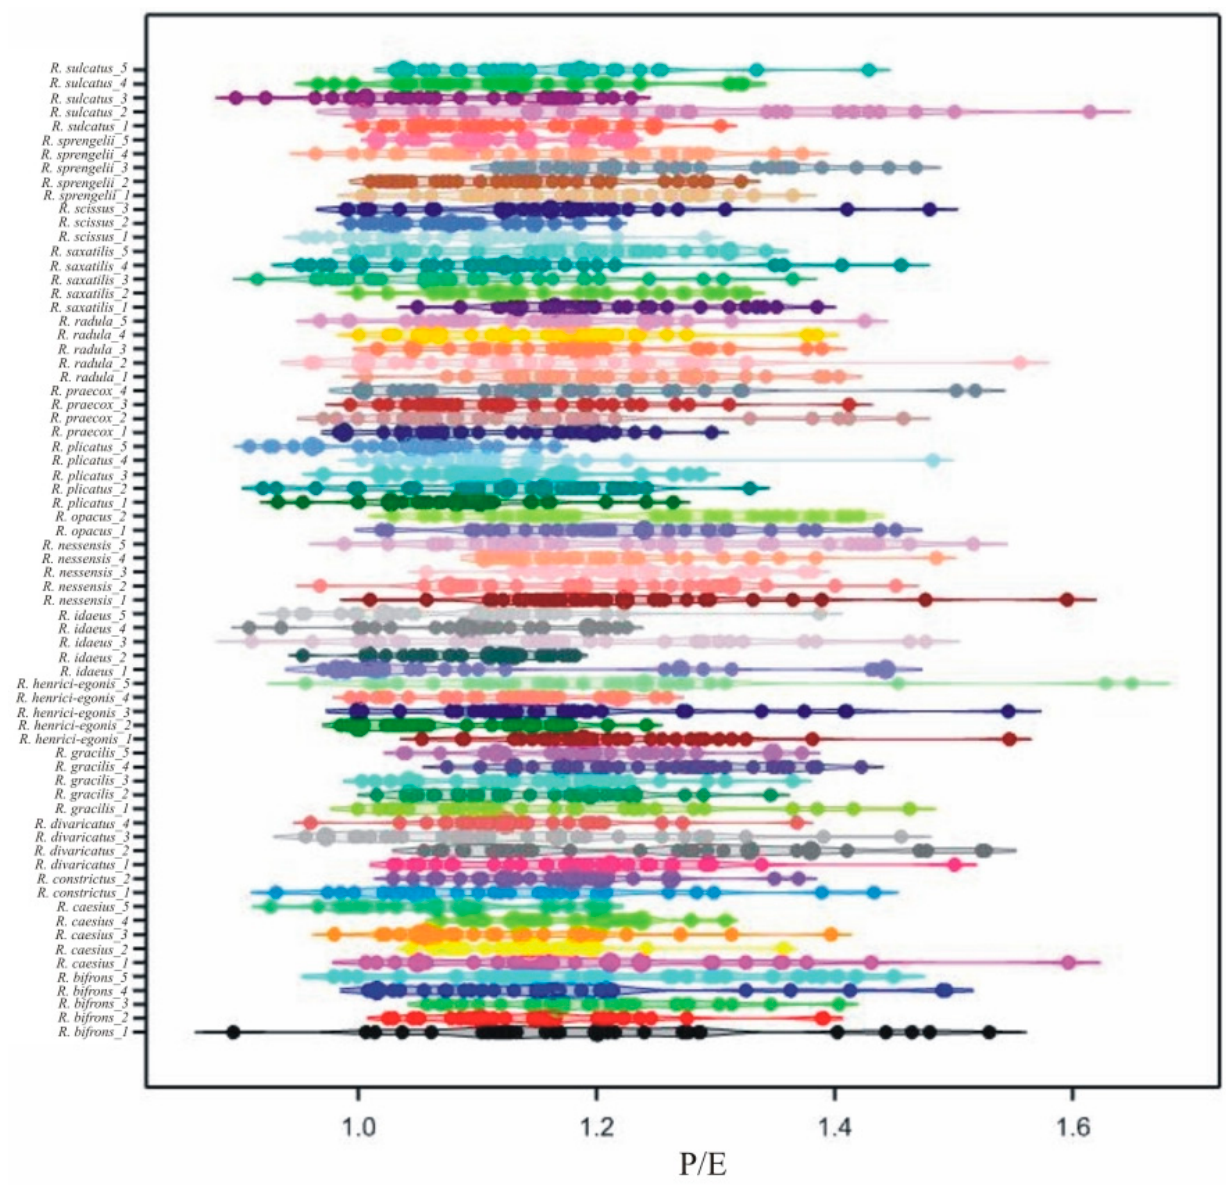
Figure 3. The density plot of P/E trait for Rubus species. The point “ • ” indicates trait observation for individual species.